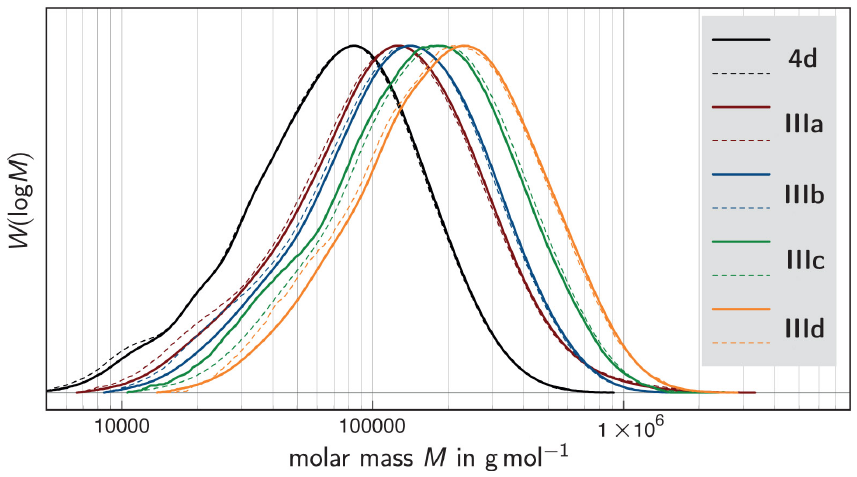
Figure 4. SEC curves (solid lines: RI signal, dashed lines: UV signal, calibration for polystyrene) for copolymerization III